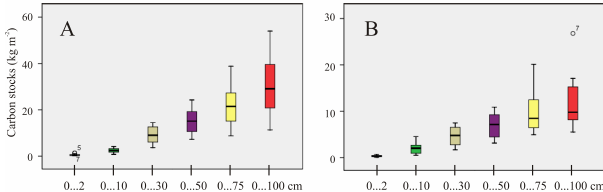
Fig. 6. The cumulative carbon stock for all six investigated depths of the Holocene river terrace (A) and of the active floodplains (B) on Samoylov Island (kgm − 2 ) . Note different scale for y-axis on the